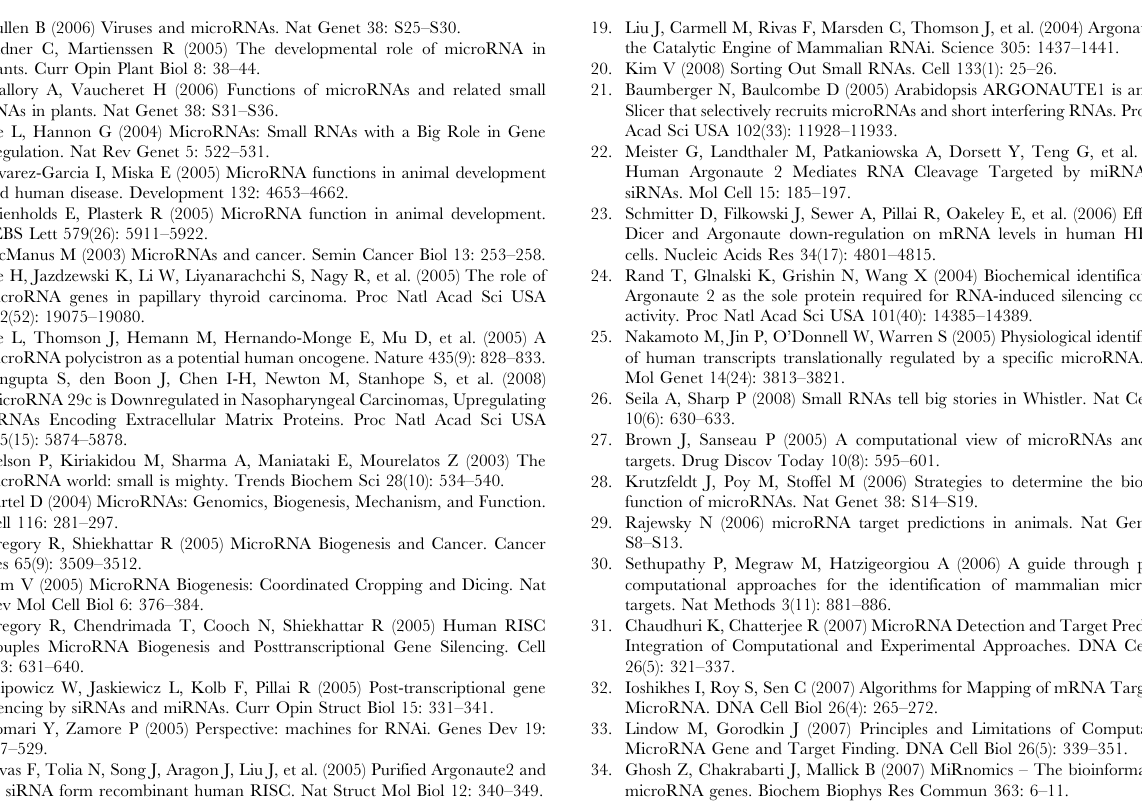
Table S2 Predicted m/miRNA target pairs. Table S2 contains the set of all predicted target pairs analyzed in this study. For each miRNA Table S2 provides the numbers of individual and simultaneous predictions made by miRBase and TargetScan for which the Madison dataset measured above noise expressions, along with a list of the genes analyzed. Predictions verified by use of model (2.3) are highlighted.